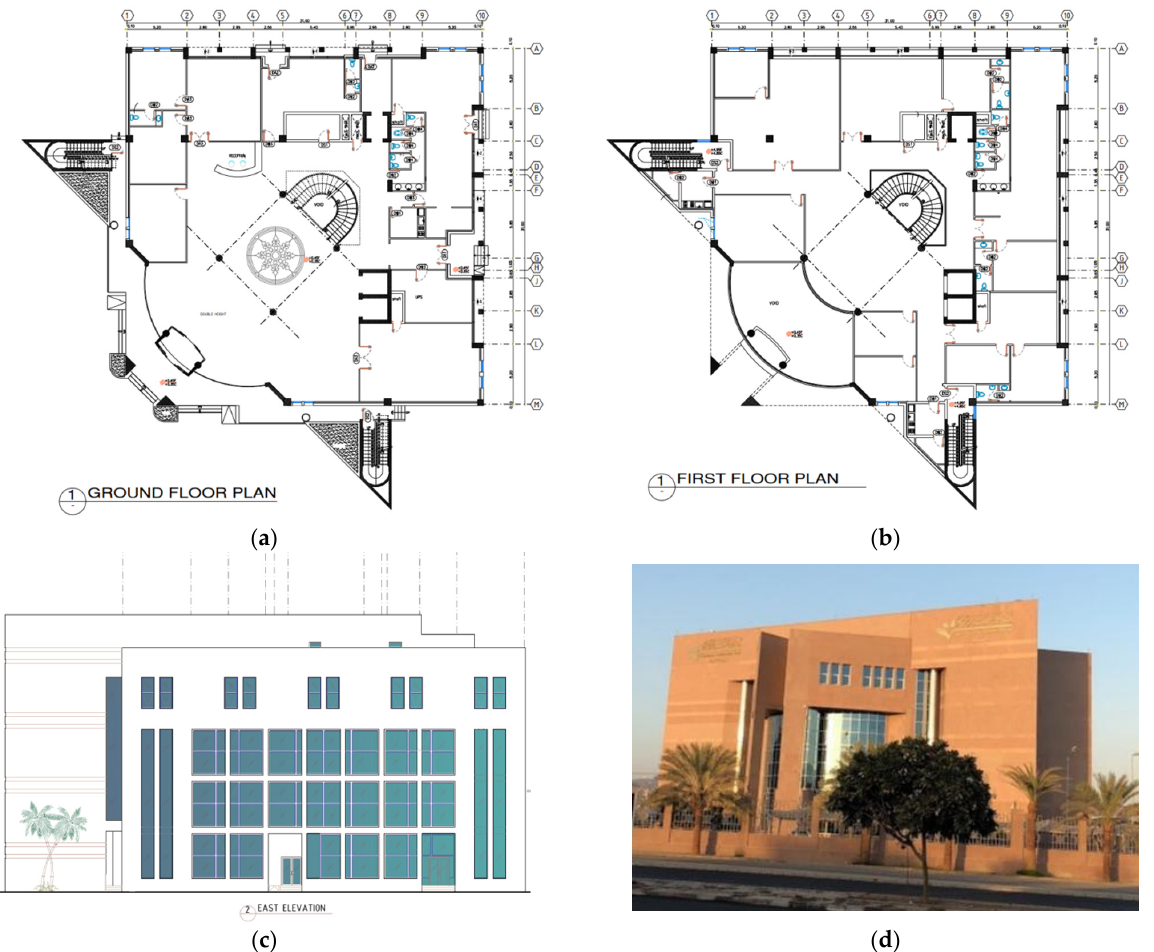
Figure 3. The Agricultural Development Fund building (ADF), ( a ) Ground floor, ( b ) First floor, ( c ) East elevation, and ( d ) Main perspective. Table 2. Building construction, HVAC, and lighting systems characteristics of the ADF building. Characteristics Description